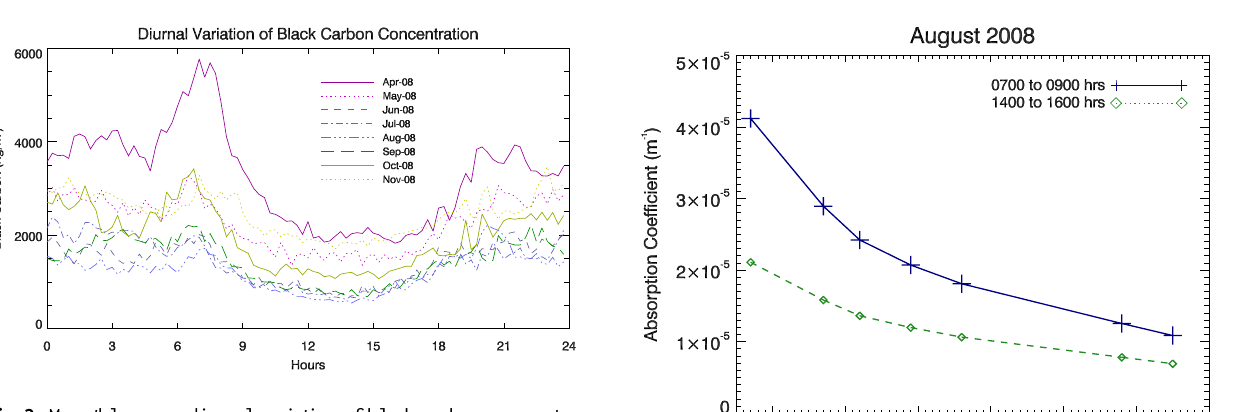
Fig. 3. Monthly mean diurnal variation of black carbon concentra- tion observed at Gadanki.